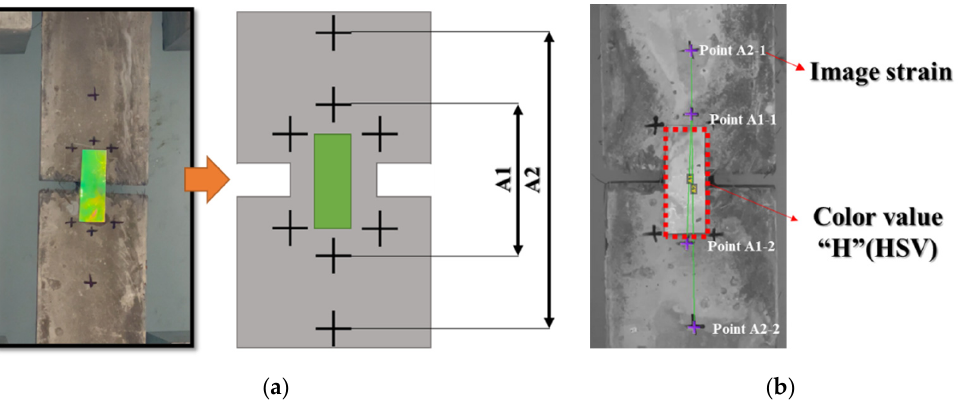
Figure 3. Analysis of deformation and discoloration extracted from images. ( a ) Spacing of cement composites for image elongation measurement; ( b ) deformation and discoloration analysis using images. Table 4. Distances (in mm) between the +-marked points on the surfaces of the freeze–thaw specimens used in the image analysis.